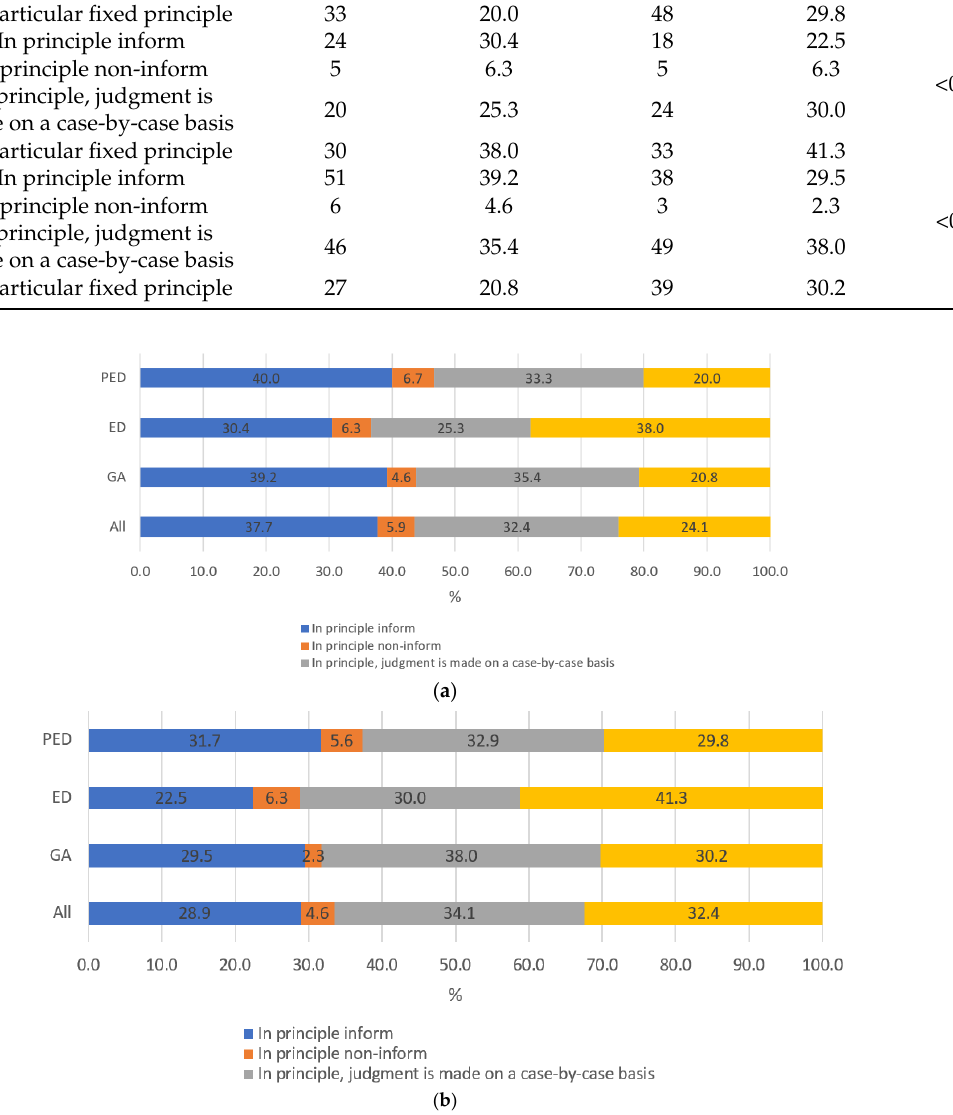
Figure 3. ( a ) Informing parents/guardians when notifying the CGC/WO; ( b ) informing par- ents/guardians when reporting to the police. Table 4. Informing parents/guardians.